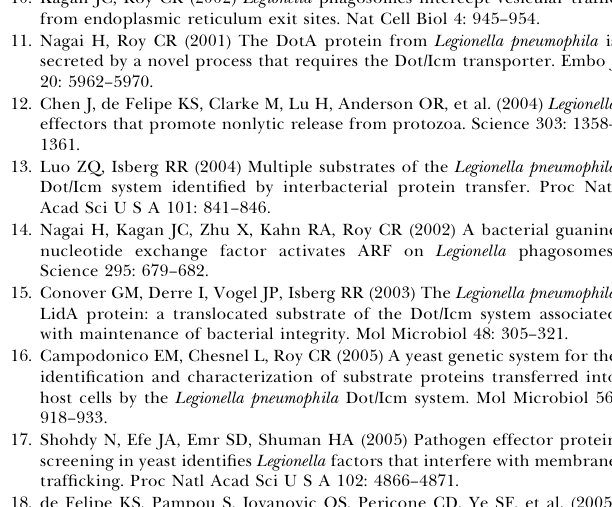
Figure S2. Mapping the icmSW Requirement for SidG Translocation (A) Schematic representation of indicated SidG truncation hybrids. Each truncation was fused in frame to the C-terminal end of Cya. Relative amino acid positions of SidG hybrids are indicated on the right. icmS/W -independent translocation was observed for each hybrid highlighted in green, while icmS/W -dependent translocation was observed for each hybrid highlighted in red. (B) CHO Fc c RII cells were infected with wild-type (black), D dotA (dark grey), or D icmS , D icmW (light grey) L. pneumophila strains expressing the indicated Cya-SidG hybrid proteins for 1 h. Total cAMP production induced by translocation of the hybrid was determined as in Figure S1. Figure S3. Contribution of lvgA to the Translocation of RalF and SidG (A) CHO Fc c RII cells were left uninfected (hatch) or infected with wild-type (black), lvgA ::TnNH3503 (dark grey), D icmS (light grey), or